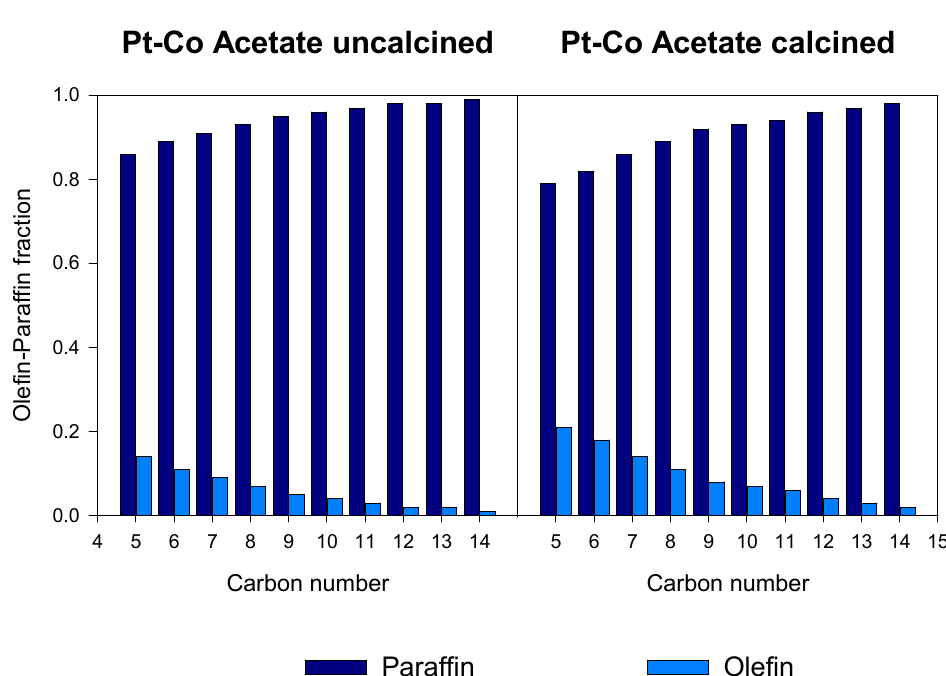
Figure 19. Fraction of olefins and paraffins for C 5 –C 14 hydrocarbons (T = 220 °C, P= 20 atm, H 2 /CO = 2 mol/mol, SV = 6 slph/g cat ).